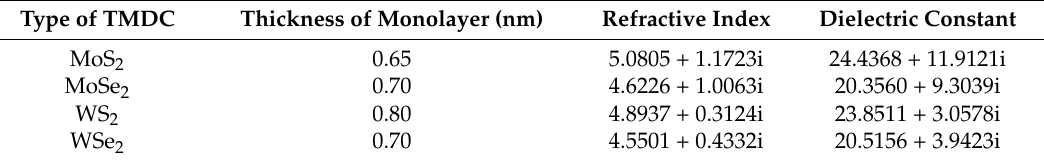
Table 1. The thickness, refractive index and optical constants of different MX 2 at λ = 633